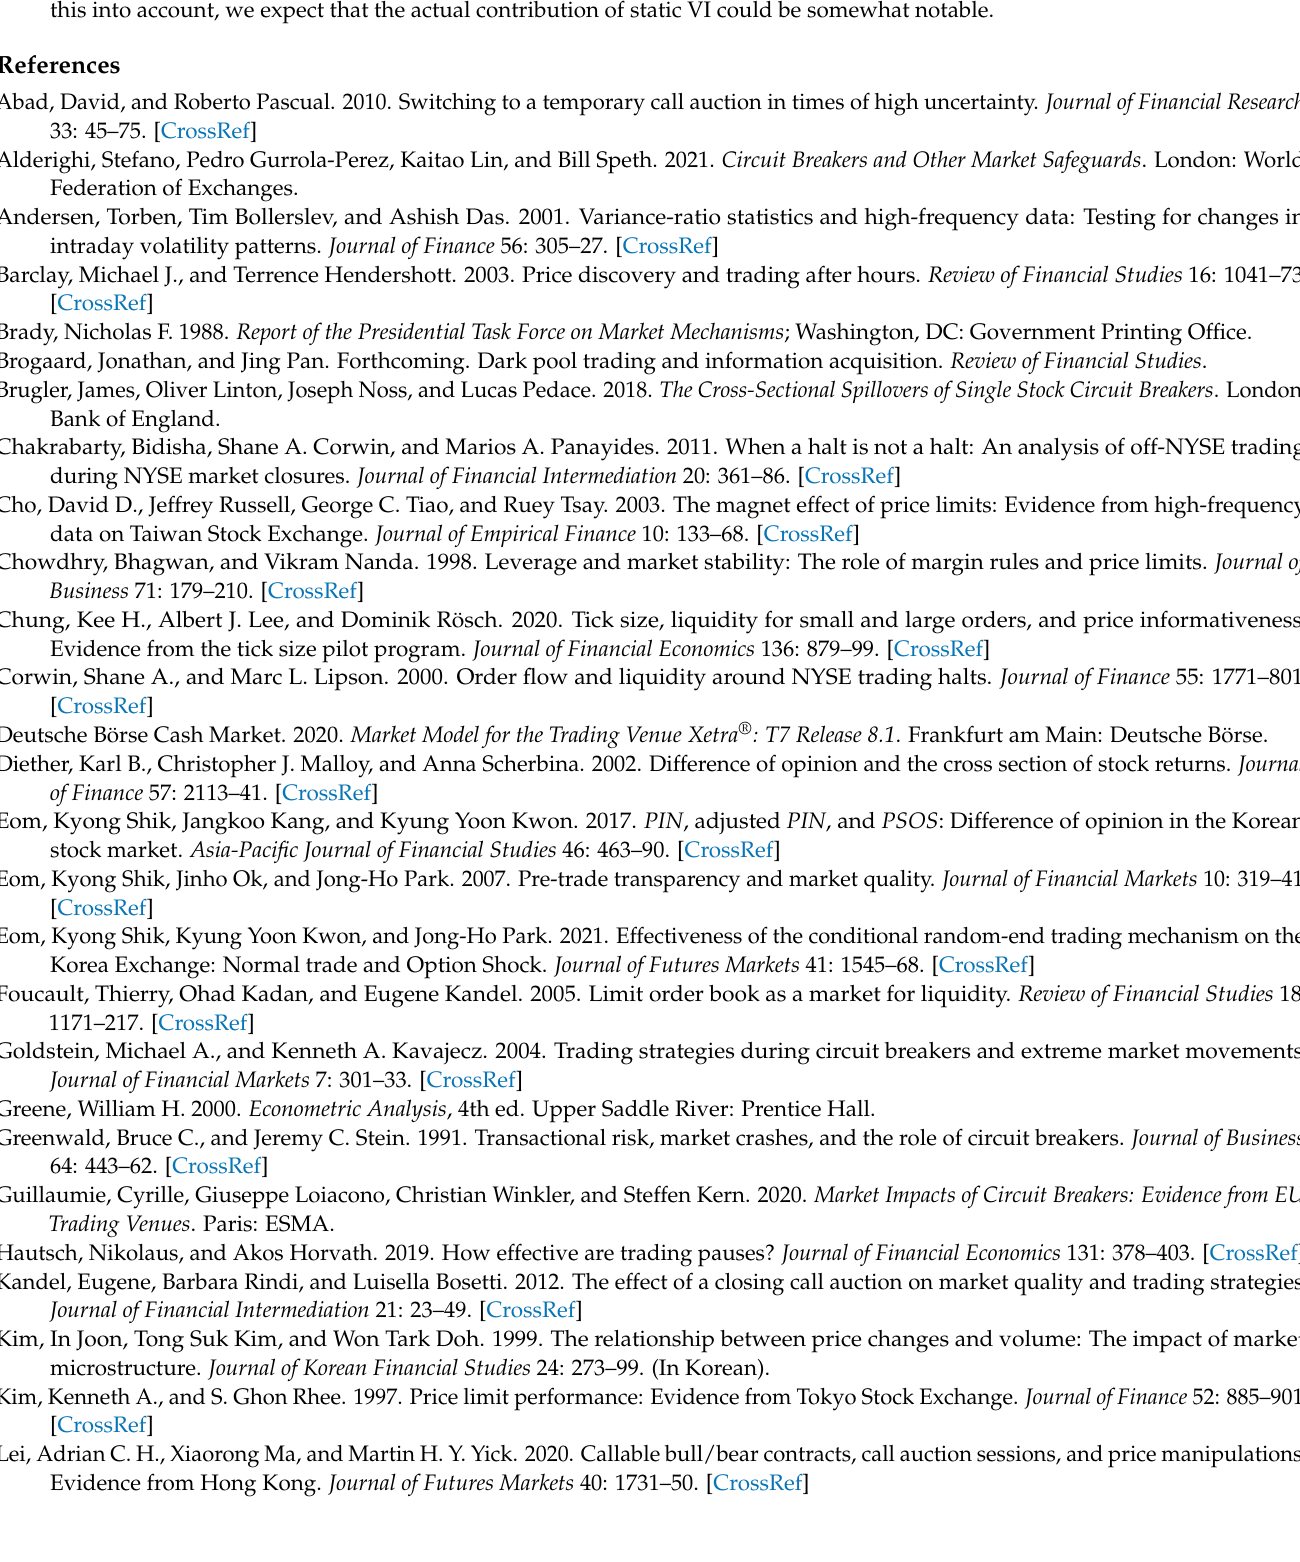
The coefficients in step 2 should be interpreted in the context of those in step 1. Annex H in Guillaumie et al. (2020) provide a useful graphical explanation for the implications of our two-step regression model. In a panel logit regression model, the marginal effect of each regressor is Λ ( x (cid:48) β )[ 1 − Λ ( x (cid:48) β )] β , where Λ is the cumulative logistic distribution function. Since the mean of the logit distribution is zero, we set x (cid:48) β = 0. Hence, Λ ( 0 )[ 1 − Λ ( 0 )] = 0.25, and the marginal effect of each regressor is 0.25 β . Substitute 0.25 β for each β coefficient (see Greene 2000, p. 817). Panel B of Table 1 shows that static VIs were much more frequently invoked than dynamic VIs in the post-event period in 2015; for example, static VIs were invoked five times more than dynamic VIs in terms of the total number of VI occurrences. Taking this into account, we expect that the actual contribution of static VI could be somewhat